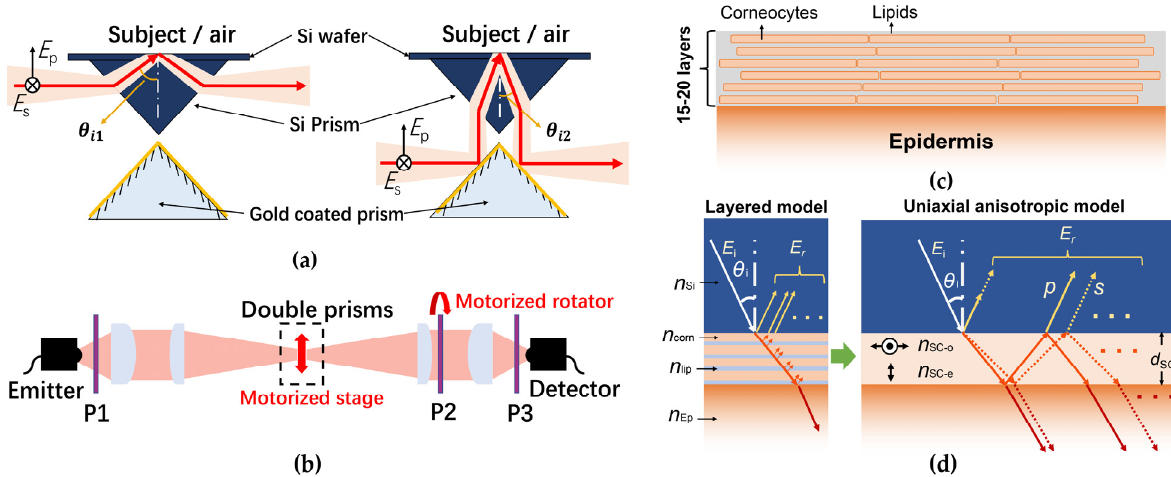
Figure 12. ( a ) Illustration of the double prism system and the two alternative THz optical paths; The double-prism system is assembled in ( b ) a THz transmission-form ellipsometer; ( c ) The “bricks and mortar” biological structure in the SC; (d) layered model ( left ) and the anisotropic skin model ( right ) [53].